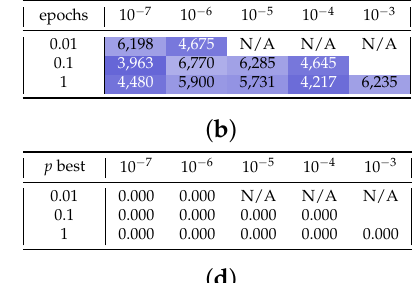
(c) p -value for the χ 2 test once convergence is reached (average (d) p -value for the χ 2 test once convergence is reached (best run). over converging runs). Figure A9. Test set H provides a sensitivity analysis on the parameters for SPSA in the discriminator. (a) Converging runs, out of 10. Experiments marked with N/A (b) Number of epochs before convergence, on average. Figure A9. The test set H provides a sensitivity analysis on the parameters for SPSA in the discriminator. The rows represent the ratio The rows represent the ratio between learning rate and perturbation factor, and the columns represent were excluded from the test set. were excluded from the test set. between learning rate and perturbation factor, and the columns represent the learning rate. Figure A9. The test set H provides a sensitivity analysis on the parameters for SPSA in the discriminator. The rows represent the ratio the learning rate. ( a ) Converging runs, out of 10. Experiments marked with N/A were excluded from between learning rate and perturbation factor, and the columns represent the learning rate. the test set. ( b ) Number of epochs before convergence, on average. ( c ) p -value for the χ 2 test once convergence is reached (average over converging runs). ( d ) p -value for the χ 2 test once convergence is reached (best run). over converging runs). Figure A9. The test set H provides a sensitivity analysis on the parameters for SPSA in the discriminator. The rows represent the ratio Figure A9. The test set H provides a sensitivity analysis on the parameters for SPSA in the discriminator. The rows represent the ratio Figure A9. The test set H provides a sensitivity analysis on the parameters for SPSA in the discriminator. The rows represent the ratio between learning rate and perturbation factor, and the columns represent the learning rate. (a) Converging runs, out of 10. (b) Number of epochs before convergence, on average. between learning rate and perturbation factor, and the columns represent the learning rate. between learning rate and perturbation factor, and the columns represent the learning rate.